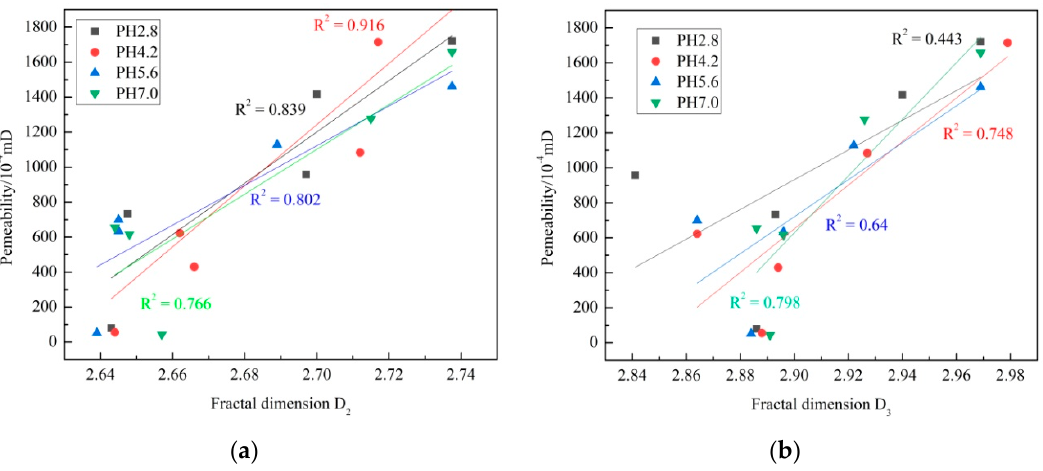
Figure 9. Correlation between permeability and segment fractal dimensions for sandstone immersed in different acidic solutions: ( a ) fractal dimensions D 2 ; ( b ) fractal dimensions D 3 .